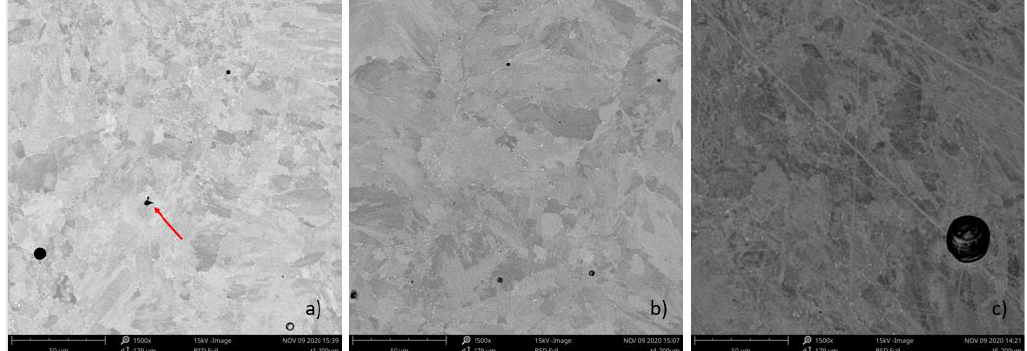
Figure 4. SEM images of spherical porosity in tube samples: ( a ) Tube A, ( b ) Tube D, ( c ) Tube E.